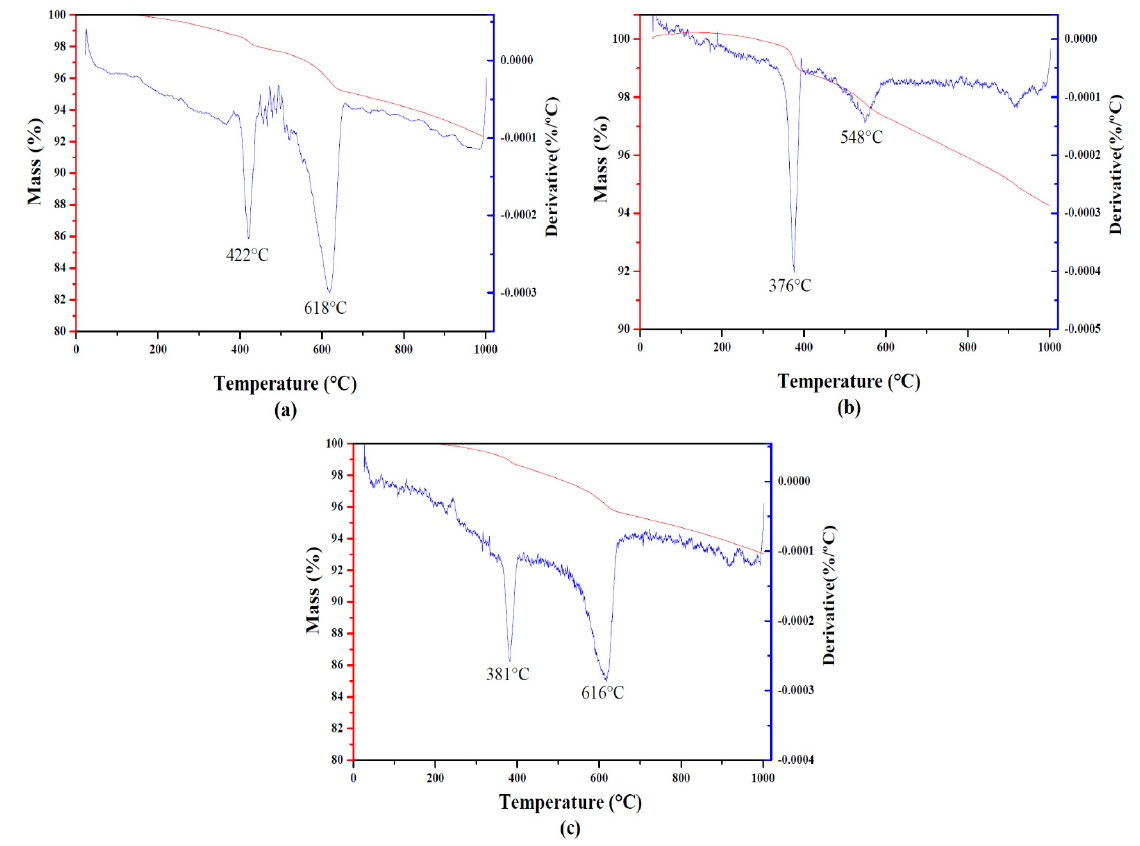
Figure 4. Thermogravimetric curves (TG/DTG) of BCP-60 ( a ), BCP-50 ( b ), and BCP-40 ( c ).